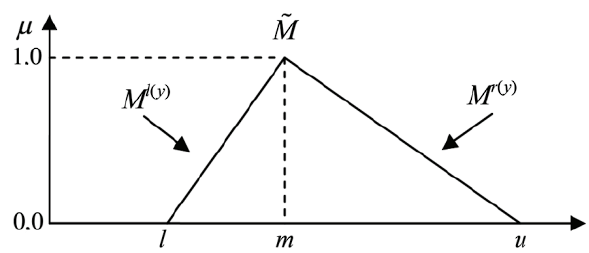
Figure 3. Triangular fuzzy number function